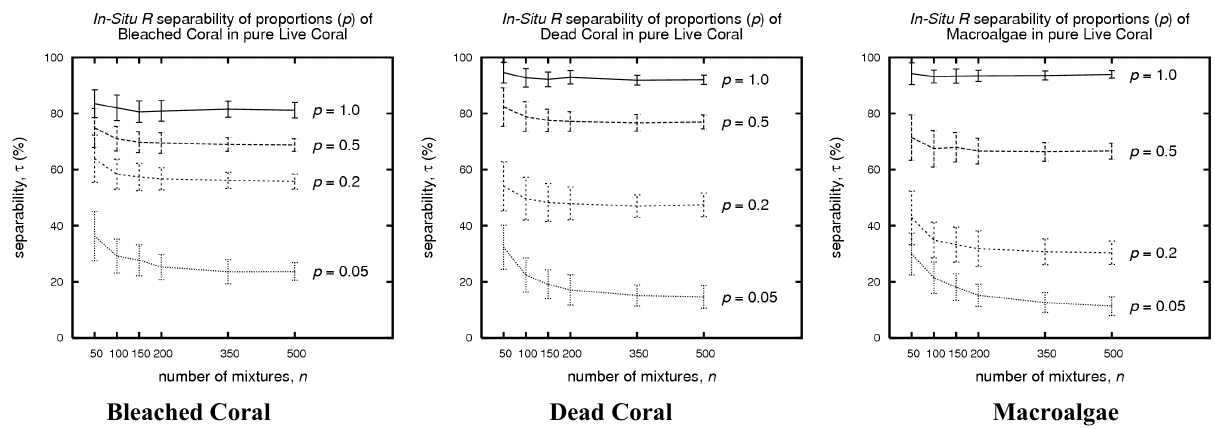
Figure 7. Separabilities of in situ reflectance spectra and determination of optimal size ( n ) of mixture sets for modelling. Benthic classes are mixtures of Live Coral with Bleached Coral, Dead Coral and Macroalgae in proportions ( p ) of 1.0, 0.5, 0.2 and 0.05, p = 1.0 corresponds to pure benthic type with no Live Coral. For each class, separability is assessed against pure Live Coral based on n randomly generated linear spectral mixtures from the library spectra. For n > 200 horizontal lines indicate the statistical variation of the library is fully exploited. Error bars: ±1 S.D. over 100